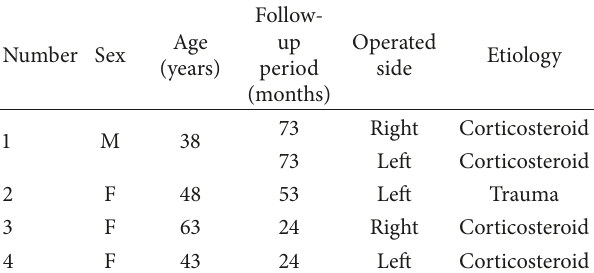
Table 1: Clinical profiles of